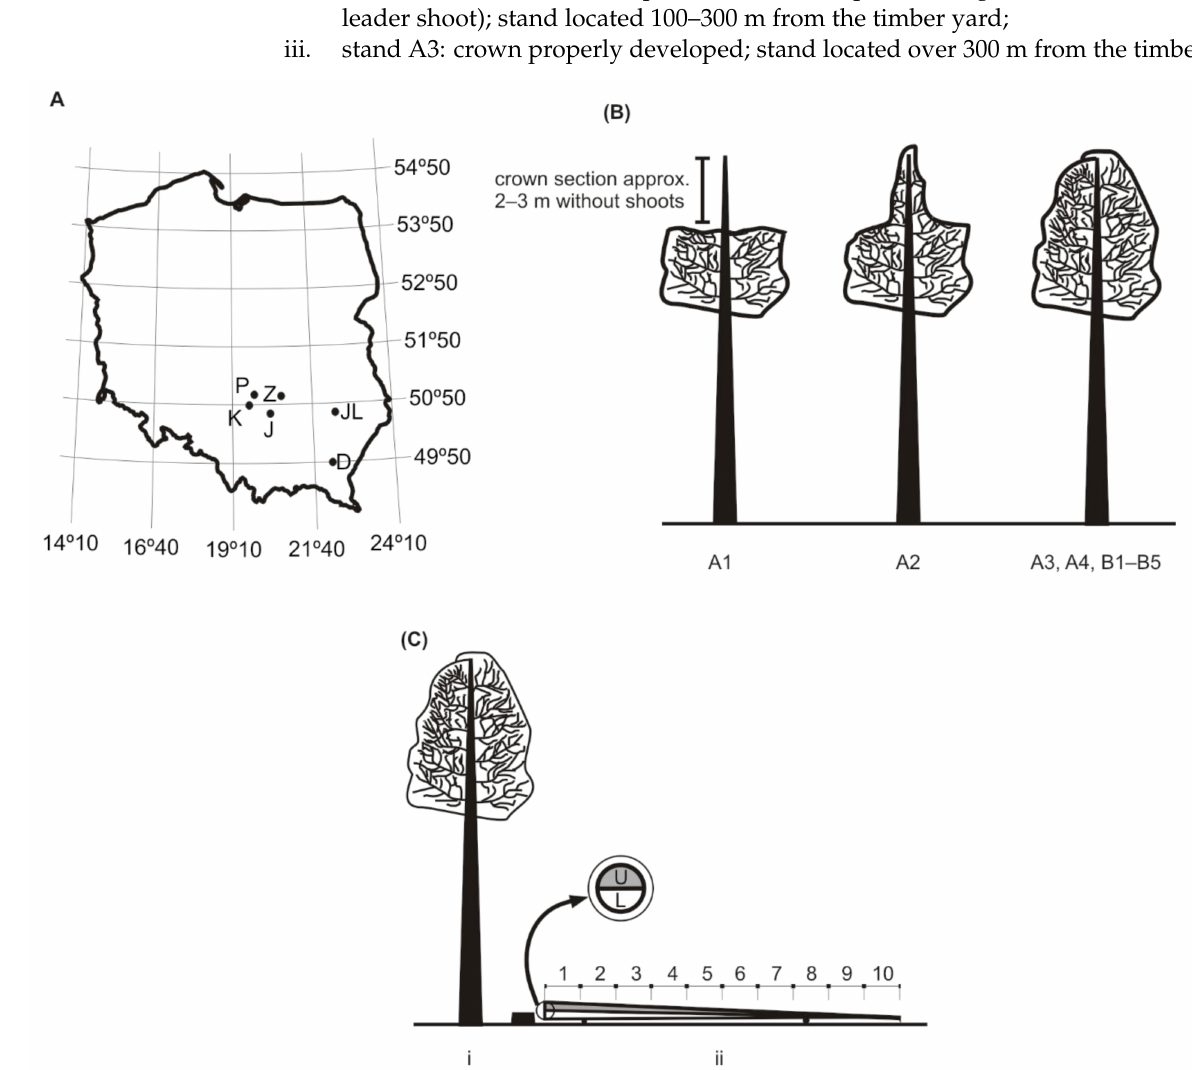
Figure 1. ( A ) Study region. Grid of the SINUS system for Poland; D, J, JL, K, P, Z symbols of the forest district—see materials and methods; ( B ) Damage to crowns in stands; ( C ) Healthy pine (i) used as a trap log (ii); letters U and L indicate the upper and lower section of the trap log, respectively. Numbers 1, 2, . . . , 10 indicate stem